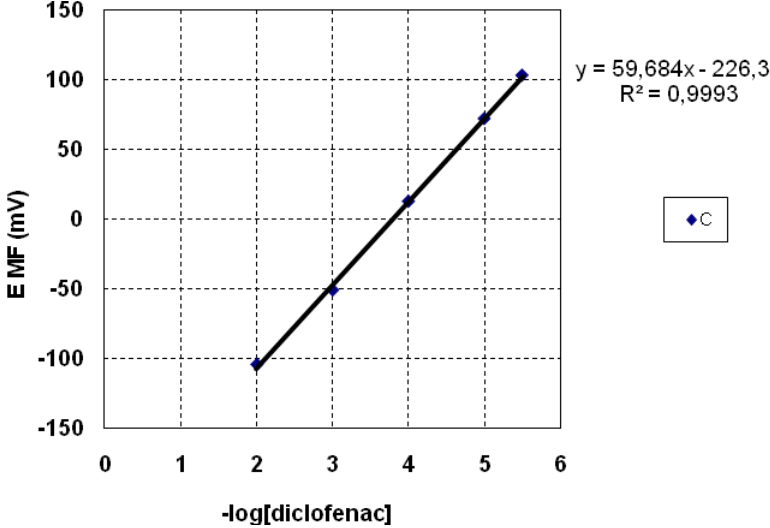
Figure 4. The potentiometric response of sensor C toward